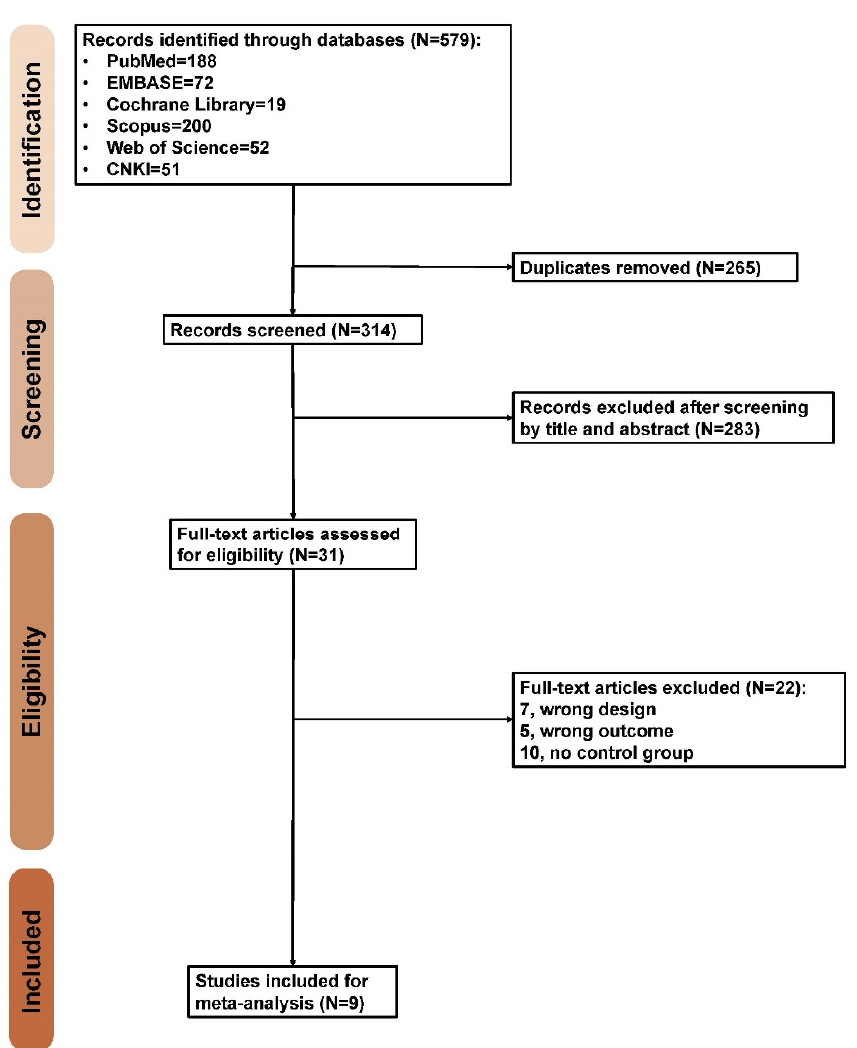
Figure 1. Preferred Reporting Items for Systematic Reviews and Meta-Analyses (PRISMA) flow diagram.